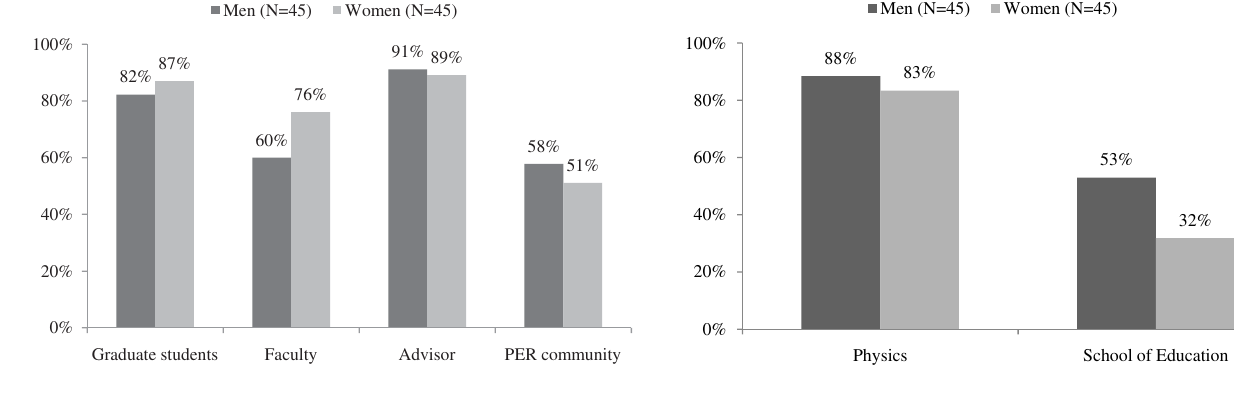
FIG. 8. Students who self-identified as a physicist by depart- ment ( p < 0 . 01